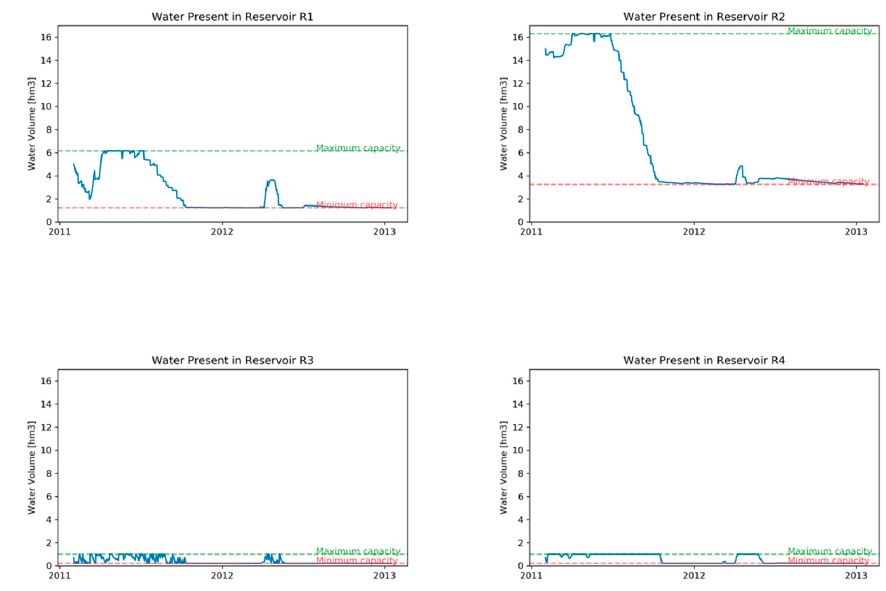
Figure 13. Water stored in reservoirs.